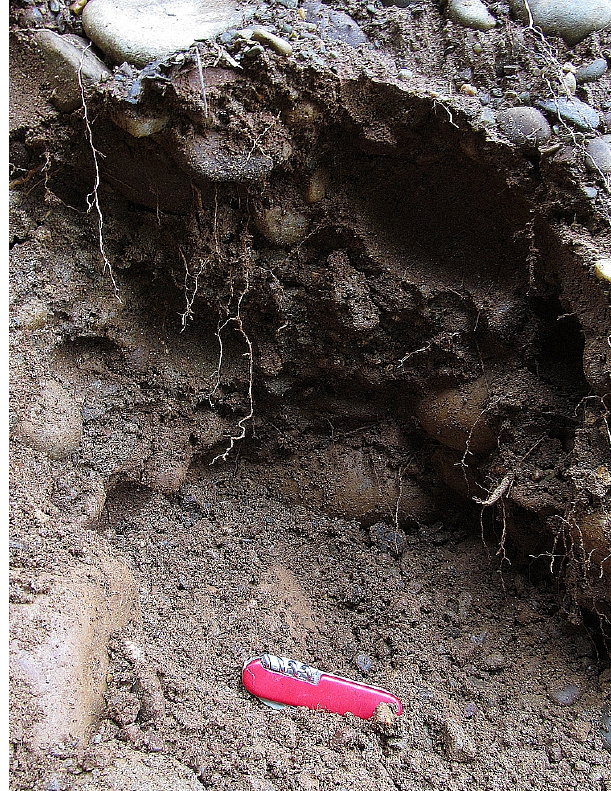
Figure A3. CDT3 – sample from base of ∼ 3 . 2m thick fill of poorly sorted fluvial pebble and cobble conglomerate, suggesting it was de- posited during a single event (approximately 26m above the mod- ern channel). OSL dated at 9760 ± 1040 years (Ray and Srivastava, 2010); 90mm long penknife for scale.